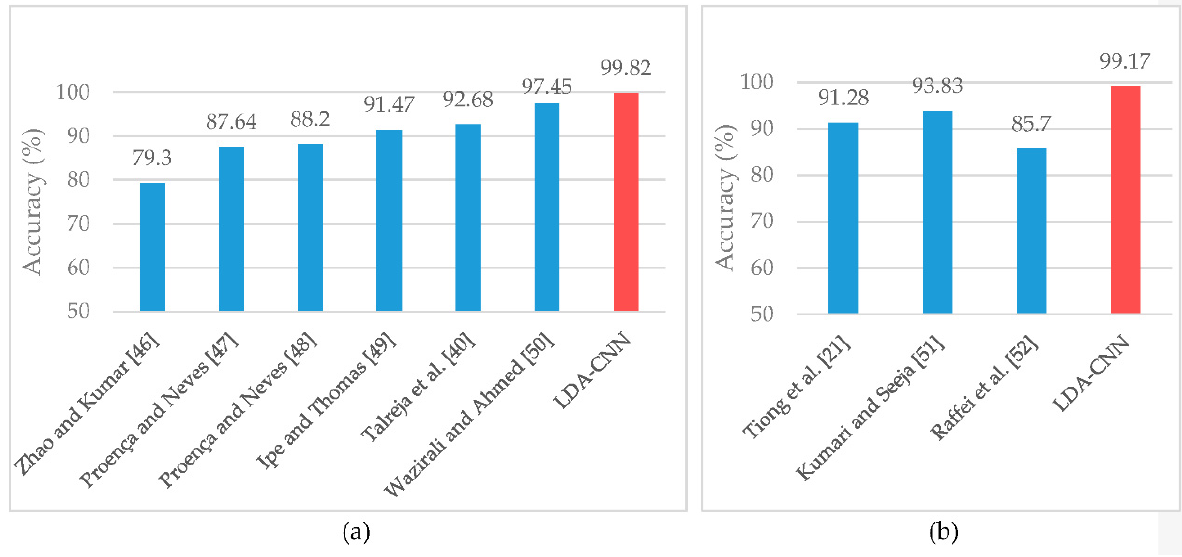
Figure 9. Comparison of the performance of LDA-CNN model with state-of-the-art methods using: ( a ) UBIRIS.v2; ( b ) UBIPr datasets. Table 7. Comparison of the performance of LDA-CNN model with existing method using VISOB dataset.